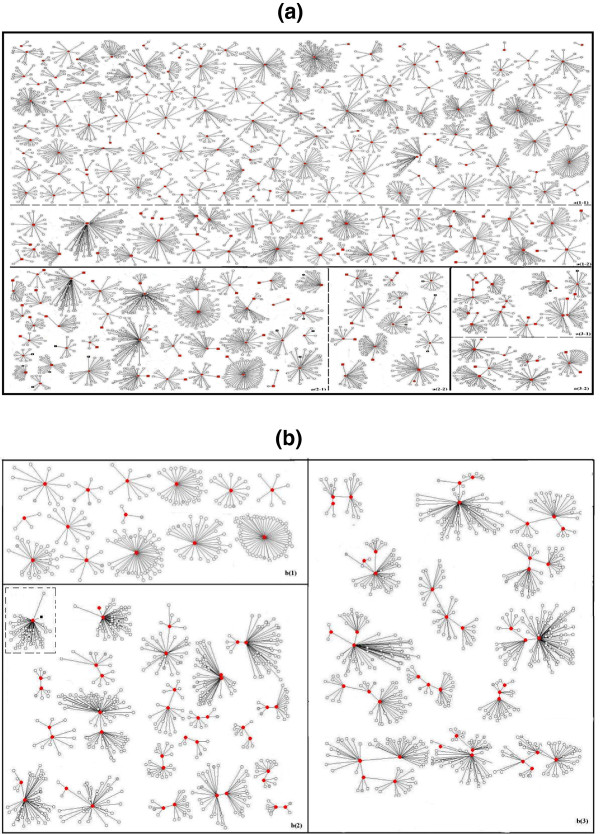
 Sexual networks (n = 290) of HIV-infected participants in Taizhou prefecture, Eastern China, 2008–2010 (with the average degree of network 13.0).(a) Sexual networks (n = 241) of heterosexually infected HIV positive participants(with the average degree of network 12.2(rang from 1 to 81)): a(1–1) sexual networks (n = 131) of male HIV positive participants with none of risky contacts tested HIV positive; a(1–2) sexual networks (n = 49) of female HIV positive participants with none of risky contacts tested HIV positive; a(2–1) sexual networks (n = 37) of male HIV positive participants with one of risky contacts tested HIV positive; a(2–2) sexual networks (n = 12) of female HIV positive participants with one of risky contacts tested HIV positive; a(3–1) sexual networks (n = 8) of male HIV positive participants with two of risky contacts tested HIV positive; a(3–2) sexual networks (n = 4) of female HIV positive participants with two of risky contacts tested HIV positive. (b) Sexual networks (n = 49) of homosexually infected HIV positive participants (i.e., HIV-infected MSM) (with the average degree of network 15.3(rang from 2 to 80)): b(1) sexual networks (n = 14) of HIV-infected MSM with none of risky contacts tested HIV positive; b(2) sexual networks (n = 11) of HIV-infected MSM with one of risky contacts tested HIV positive. The one inside the small dashed square represents the network of an HIV-infected MSM whose wife tested HIV positive. b(3) sexual networks (n = 24) of HIV-infected MSM with two or more of risky contacts tested HIV positive. Red or dark dots represent male HIV positive participants; Red or dark squares represent female HIV positive participants; Grey dots represent risky contacts who tested HIV negative in the present survey; Circles represent risky contacts who did not receive HIV testing. Hollow dots or squares represent HIV-infected individuals who refused to participate in the present survey.